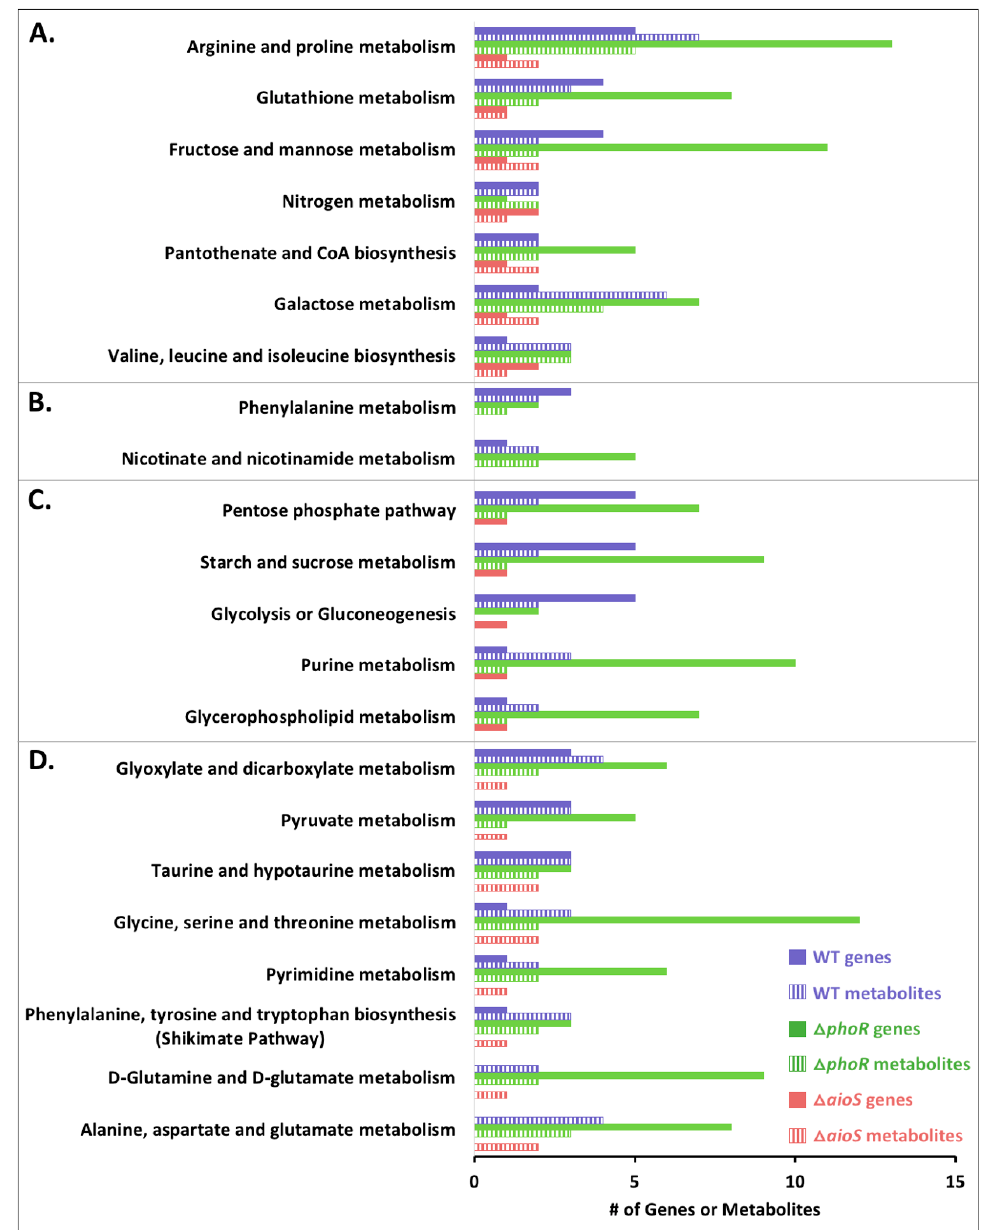
Figure 2. Cellular functions perturbed by As III in WT and mutants, which contribute to observed differences between treatments. Only genes and metabolites that were different in pairwise comparisons (WT +/- As III ; mutant + As III vs. WT + As III ) are shown. Data was classified by KEGG pathways. ( A ) Pathways perturbed at the transcript and metabolite levels in the WT + As III and in both mutants + As III . ( B ) Pathways altered at the transcript and metabolite levels in the WT + As III and in the Δ phoR mutant + As III . ( C ) Pathways altered at both the transcript and metabolite levels in the WT + As III and the Δ phoR mutant + As III , but only at the transcript level in the Δ aioS mutant + As III . ( D ). Pathways regulated in the WT + As III , both at the transcript and metabolite levels in the Δ phoR mutant + As III , but only at the metabolite level in the Δ aioS mutant + As III .